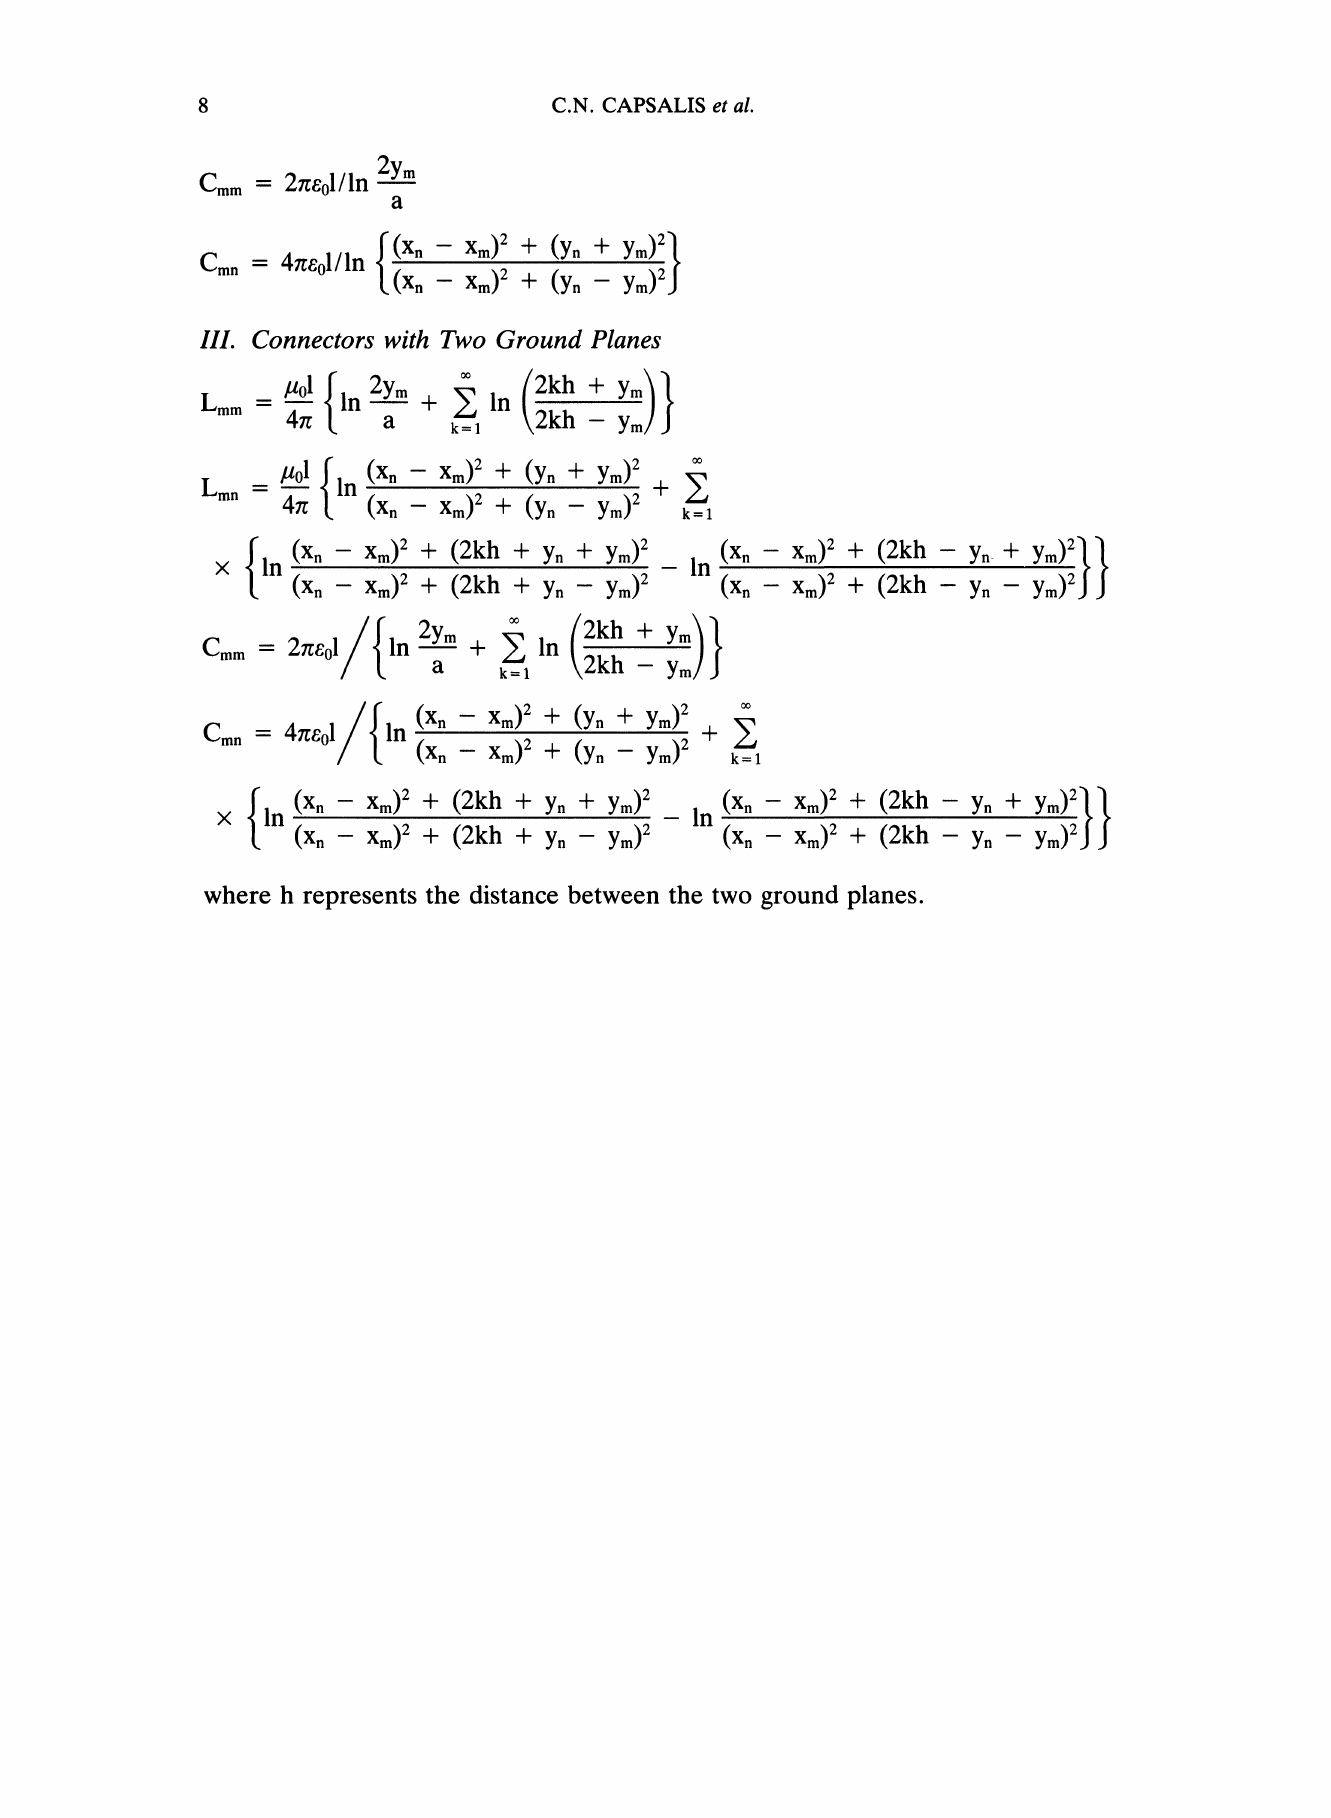
where h represents the distance between the two ground